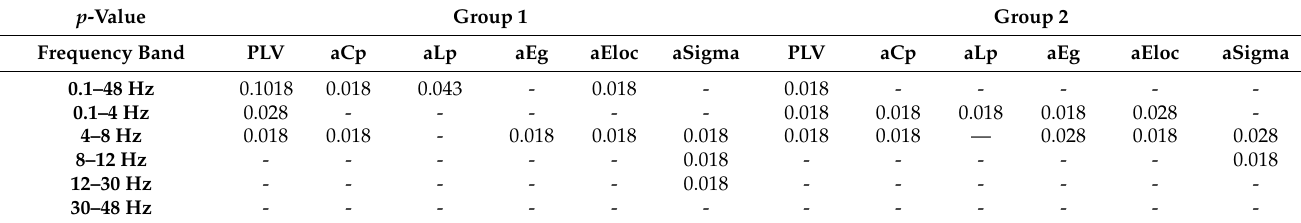
Figure 13. Brain network indicators (aCp, aLp, aEg, aEloc, and aSigma) for all filtered frequency bands (delta 0.1–4 Hz, theta 4–8 Hz, alpha 8–13 Hz, beta 13–30 Hz and gamma 30–48 Hz) and the broad-filtered EEG (0.1–48 Hz). ( A – E ) Within-group comparisons of brain network indicators at different stages. ( F – J ) Between-group comparisons of brain network indicators between Group 1 and Group 2 (‘Sonication’ represents Group 1 and ‘Control’ represents Group 2). * indicates significance ( p < 0.05), (cid:78) represents a significant difference between Stage 1/1* and Stage 2/2* ( p < 0.05). Table 2. Within-group comparisons of weighted brain